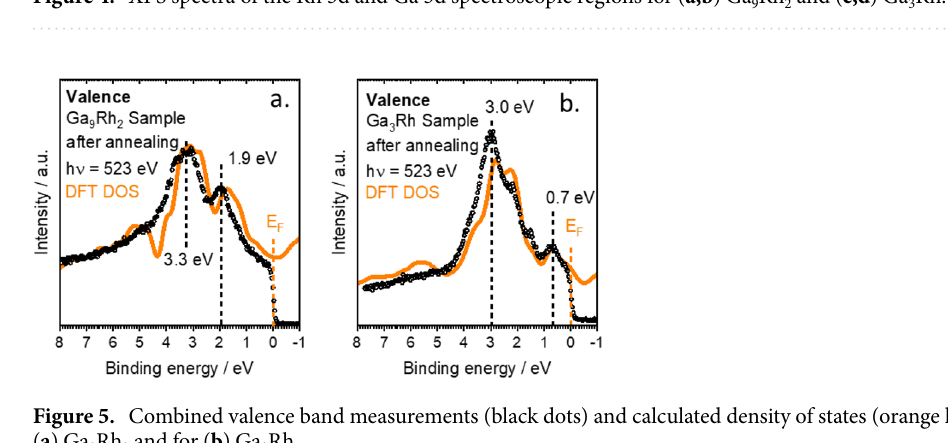
Figure 4. XPS spectra of the Rh 3d and Ga 3d spectroscopic regions for ( a,b ) Ga 9 Rh 2 and ( c,d ) Ga 3 Rh.